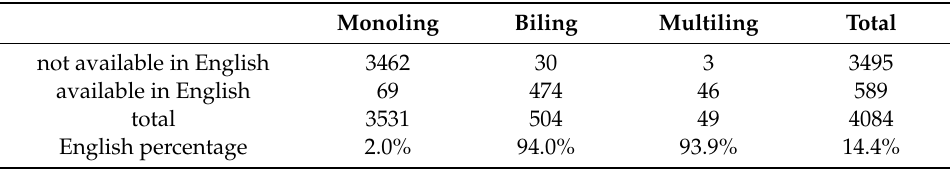
Table A12. English language availability (cz).